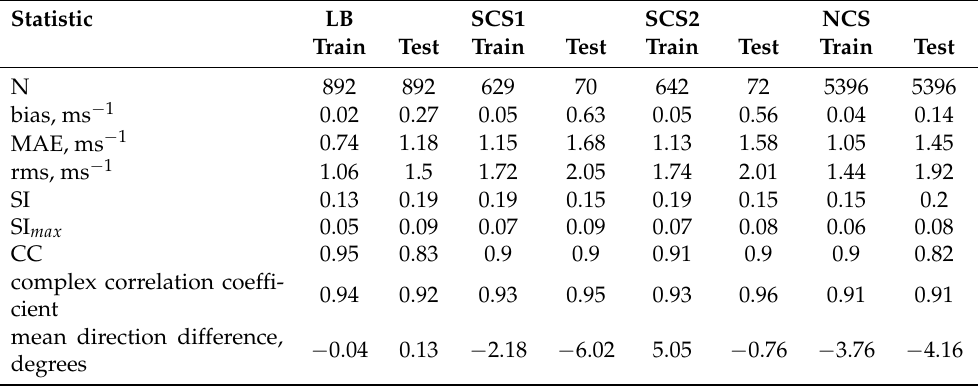
Figure 5. Comparison of north Celtic Sea SVR wind speeds with model speeds. Left : training Right : test. Colour-coding is number of cases in each bin. Table 5. Statistics of the SVR wind speed and wind vector for train and test data